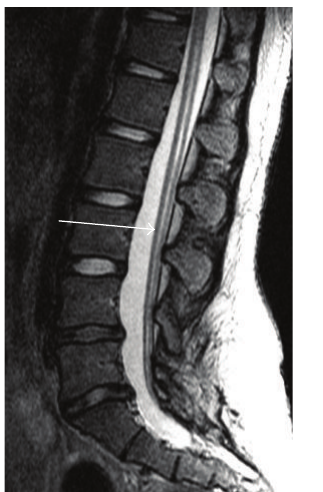
Figure5:SagittalT2-weightedmagneticresonanceimagingshowed a tethering cord with a fatty filum terminale (white